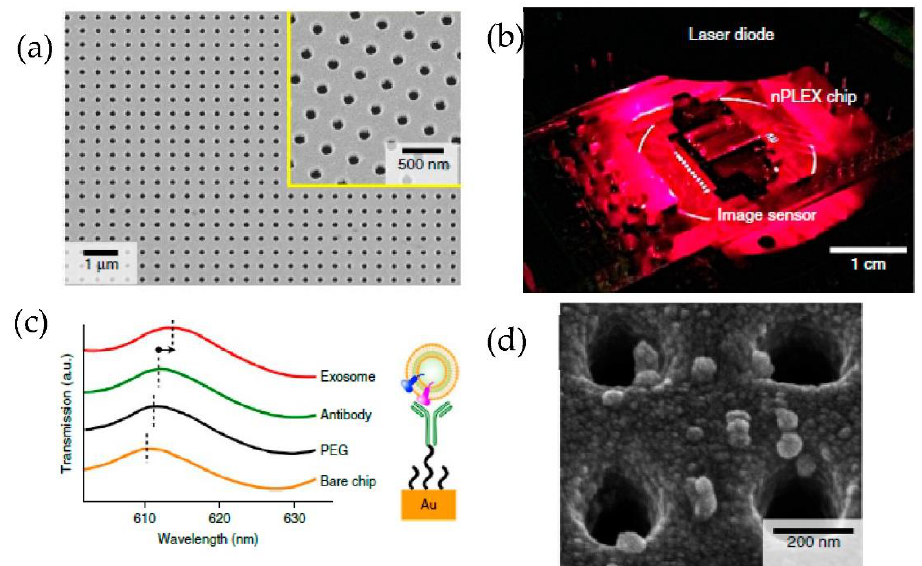
Figure 17. Label-free detection of exosomes with the nPLEX sensor. ( a ) A scanning electron image of the periodic nanoholes in the nPLEX sensor. ( b ) A prototype of the nPLEX imaging system. ( c ) Schematic to represent the changes in transmission spectra to show the exosome detection with the nPLEX device. ( d ) Scanning electron microscopy image showing the exosome capture near the nanohole array. (Reproduced from Im H. et al. [82]. Copyright 2014, Nat